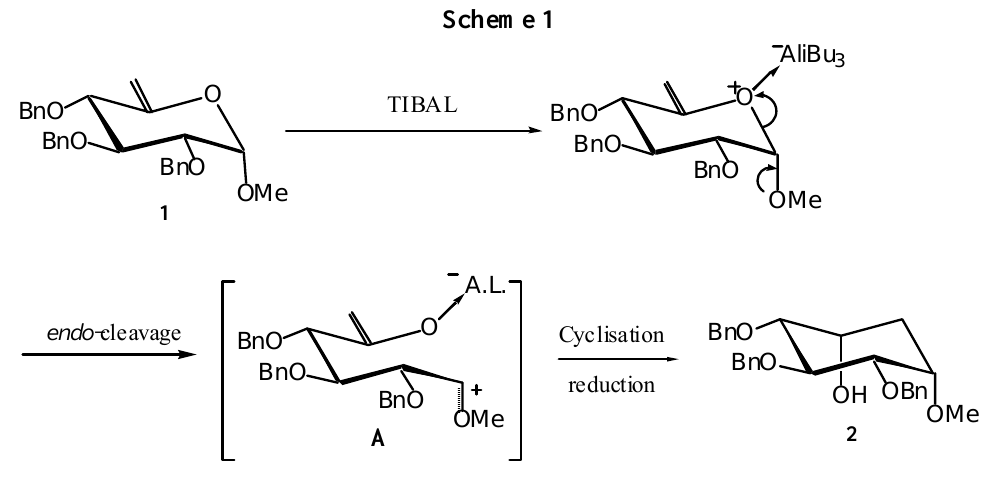
OHHO NHHO OH O O OH (+)-pancratistatine